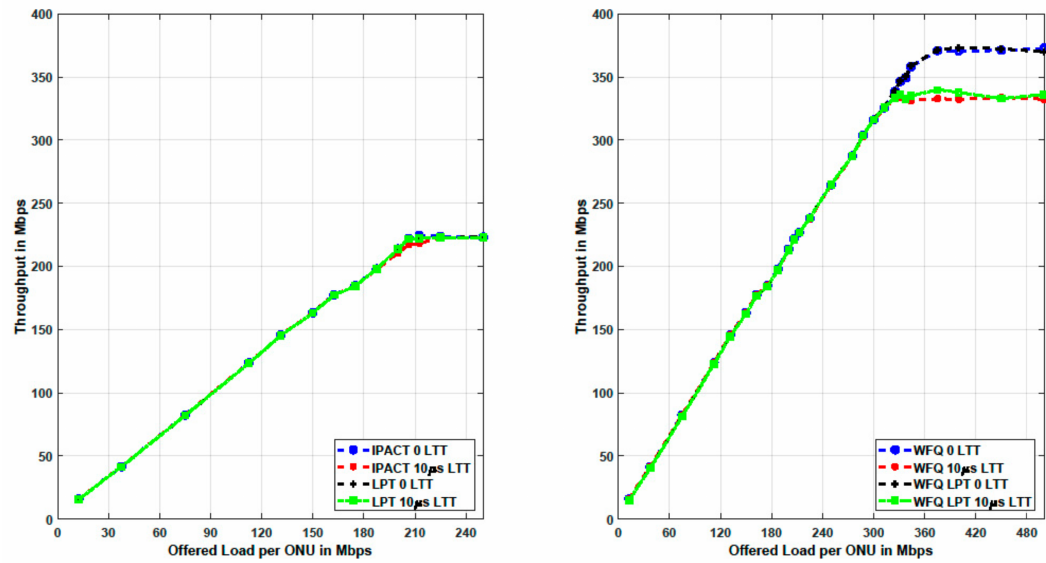
Figure 3. Throughput for ONU 1 at both LTT = 0 µ s and LTT = 10 µ s in a 16-ONU scenario; IPACT and LPT ( left ); and WFQ and WFQLPT ( right